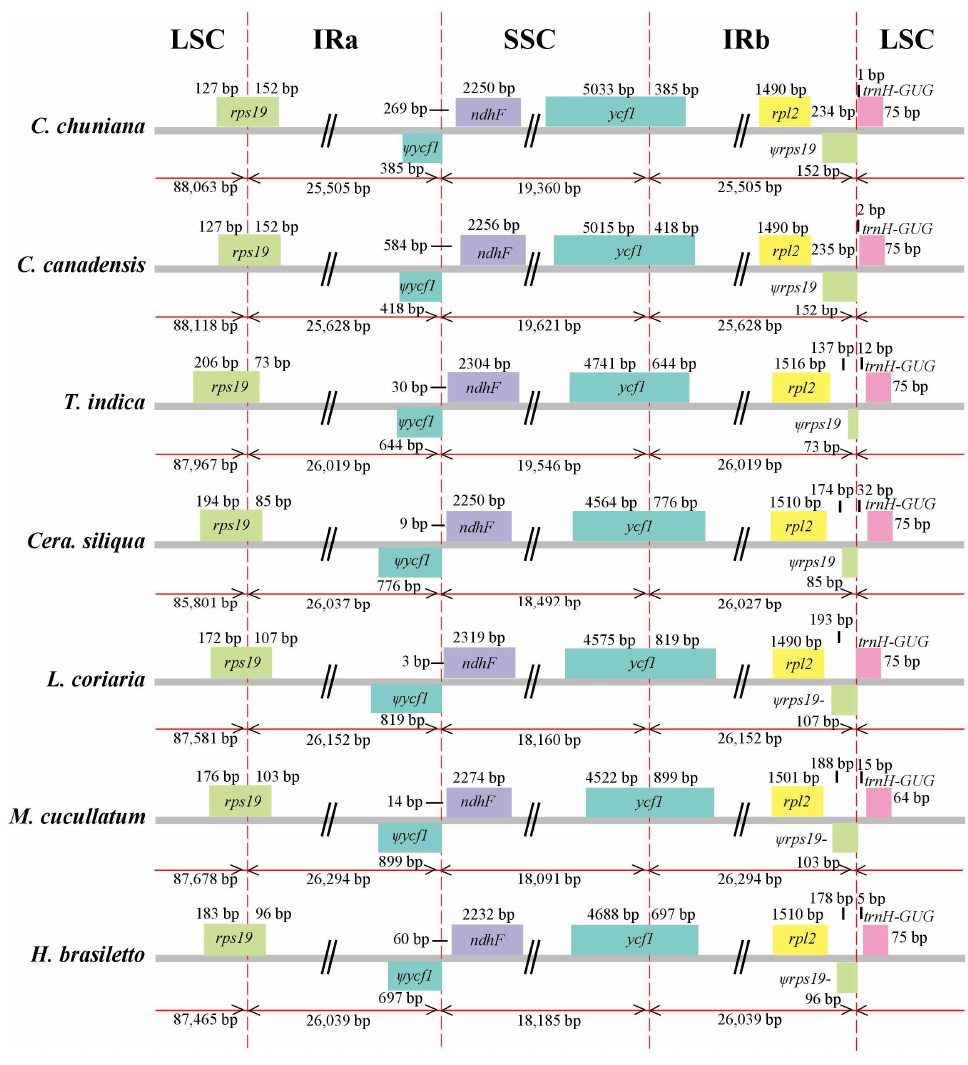
Figure 2. Comparison of the border positions of LSC, SSC and IR regions among the seven species of caesalpinioid legumes compared in this study. Genes are denoted by colored boxes. The gaps between the genes and the boundaries are indicated by the base lengths (bp). Extensions of the genes are indicated above the boxes.